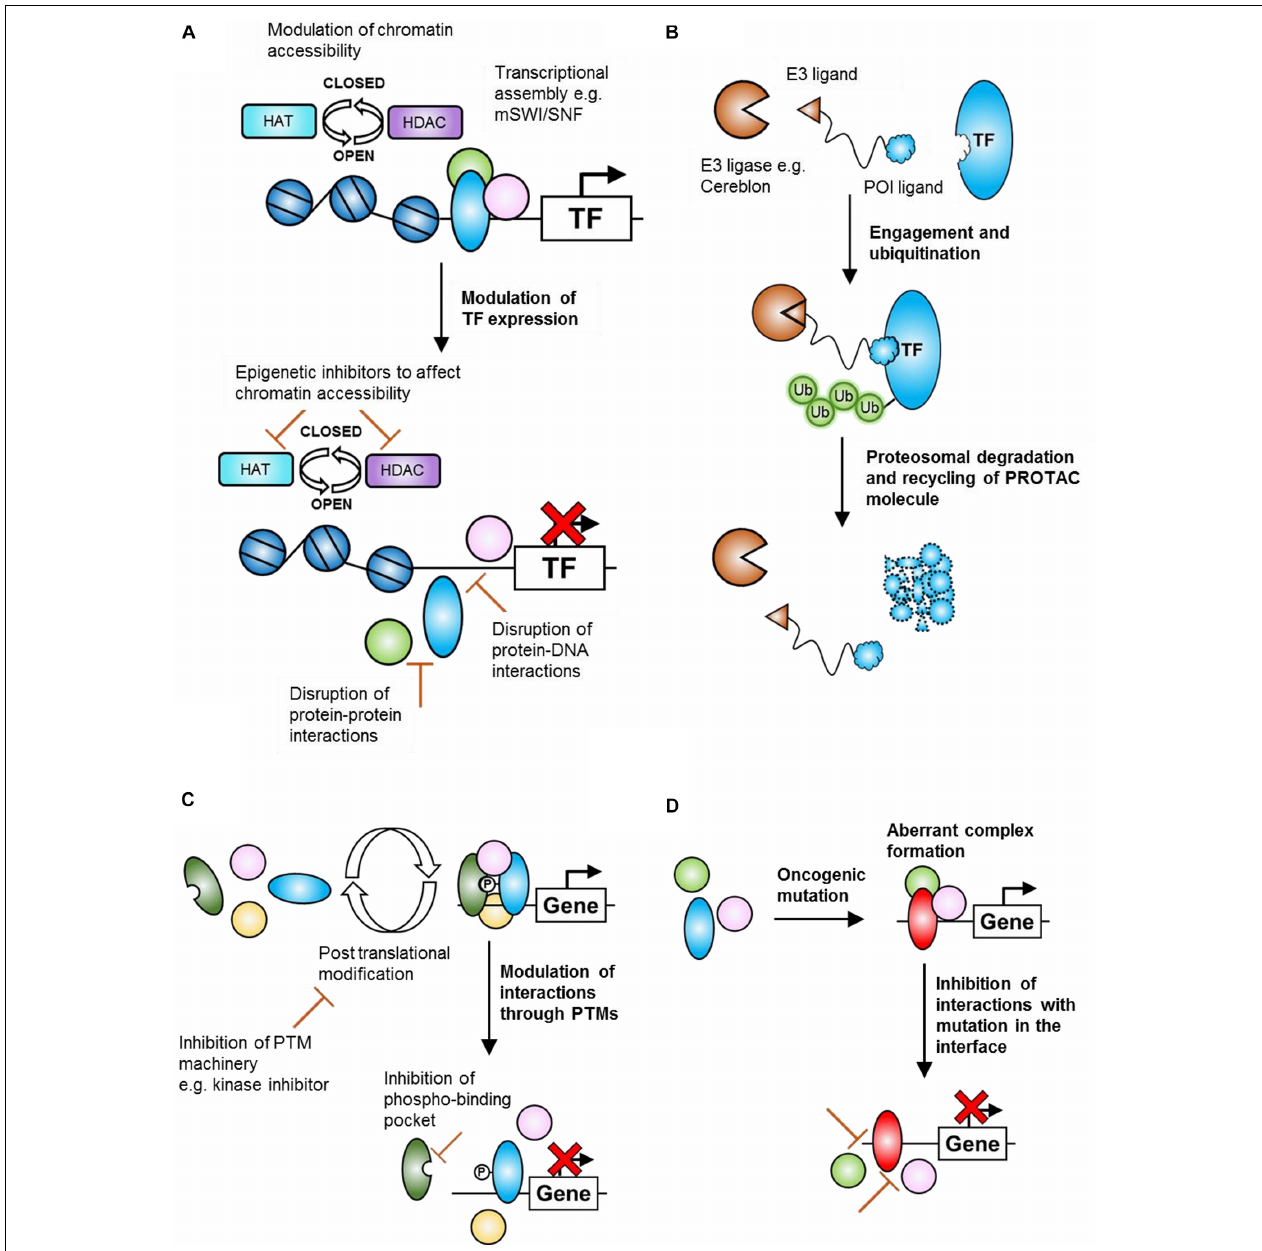
FIGURE 2 | Potential mechanisms of transcription factor (TF) targeting for cancer therapy. (A) Inhibition of oncogenic TF expression. This may take the form of altering chromatin accessibility, through inhibitors of epigenetic machinery, or by disrupting the assembly of transcriptional machinery at the protein-protein or protein-DNA binding level. (B) Depletion of oncogenic proteins by PROTAC-mediated proteasomal degradation. A bi-functional molecule containing a protein of interest-binding region and an E3-ligase binding region links the protein of interest to an E3-ligase, leading to ubiquitination and proteasomal degradation. (C) Inhibition of TF function through modulation of post-translational modifications. Assembly of oncogenic transcriptional (or epigenetic) assemblies may rely on post-translational modifications. Inhibiting the enzymes responsible for these modifications or inhibiting the binding pocket of the specific modification may represent feasible options for preventing the assembly of oncogenic transcriptional assemblies. (D) Inhibition of mutation-dependent transcriptional assemblies. Structural information regarding the binding interfaces of mutated transcriptional or epigenetic proteins may allow for the design of therapies that inhibit mutation-dependent interactions and prevent the assembly of mutation-dependent transcriptional